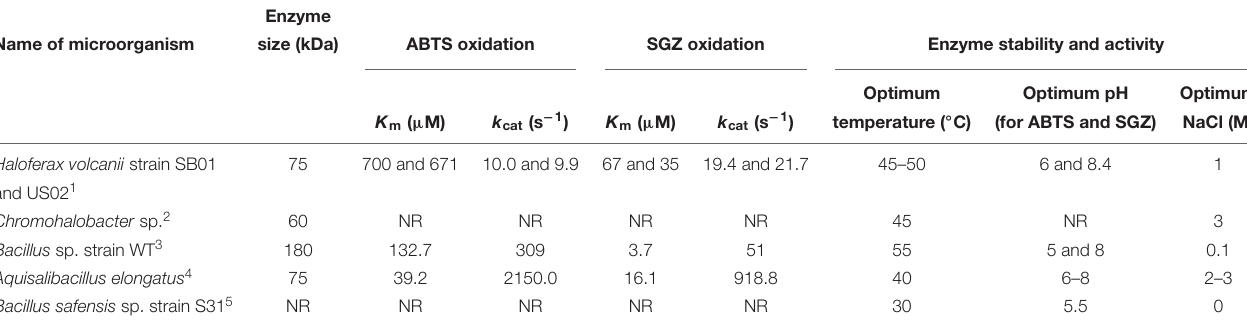
TABLE 3 | Purified laccase enzymes from halophilic archaea and bacteria ∗ .